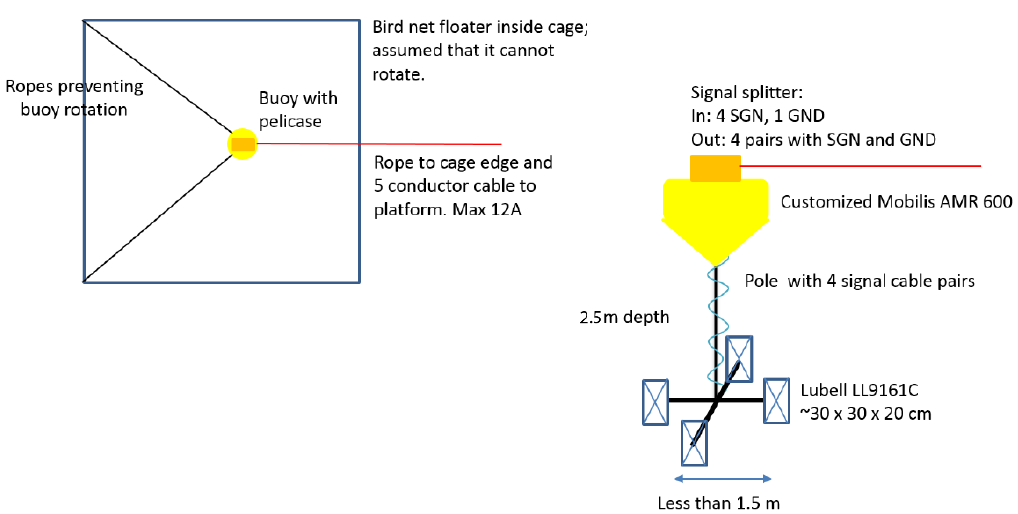
Figure 4. Drawing of the experimental setup. Note that the depth of the structure that holds the loud speakers was modified along the duration of the experiments. M9 loud speakers were lowered to − 5 m [3].